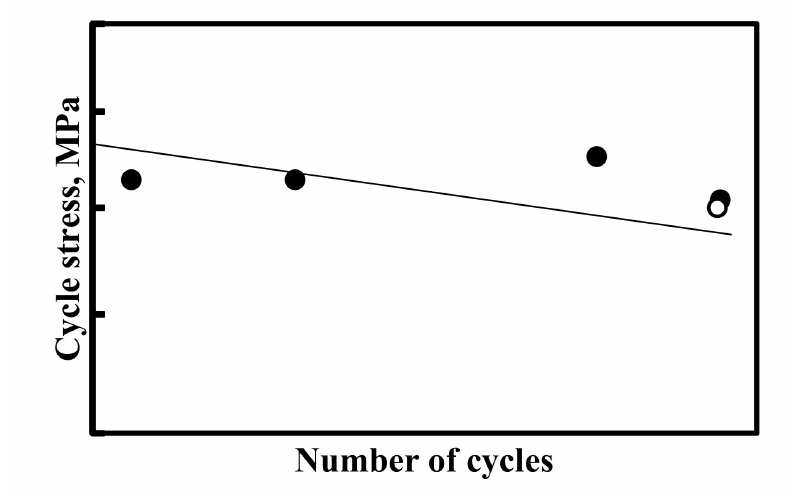
Figure 10. Fatigue curve of structural elements ( —has broken/suspected breakage; —did not